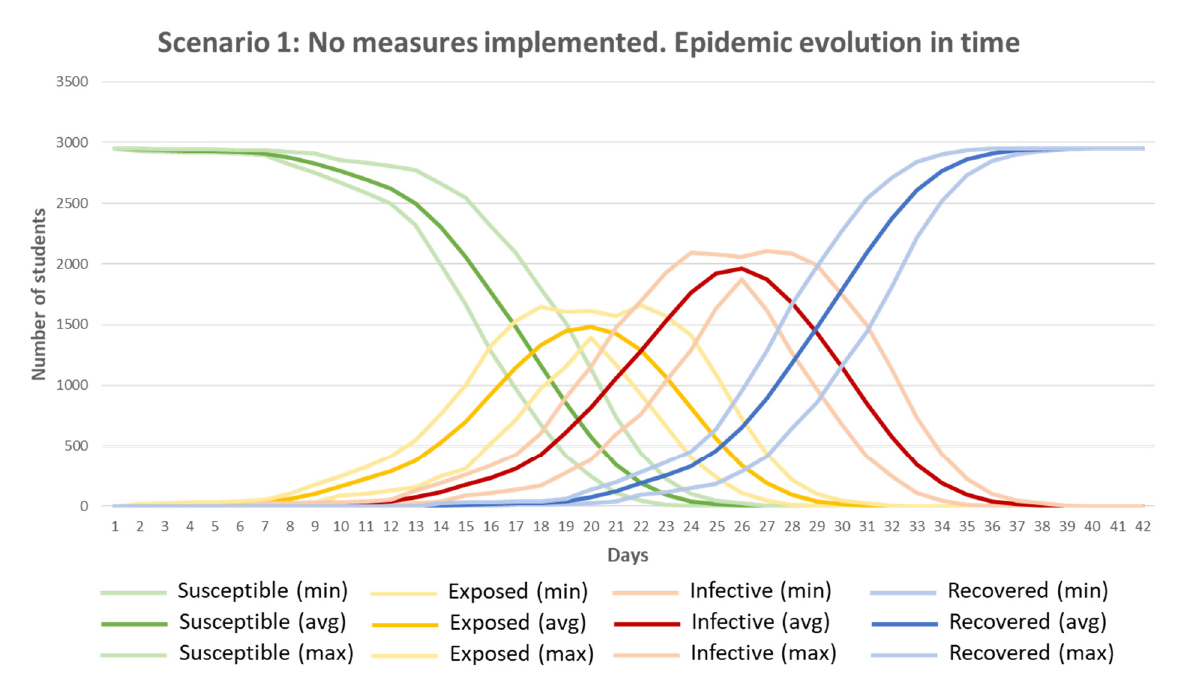
Figure 13. Scenario 1. No measures implemented. Minimum, maximum and average values obtained from the 20 developed simulations for number of Susceptible (green), Exposed (yellow), Infective (red), and Recovered (blue) student agents over time.